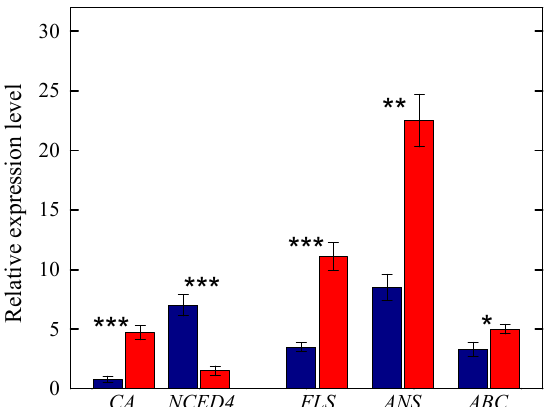
Figure 3. Relative expression levels of selected genes regulating the synthesis of MEP- ( CA , NCED4 ) and flavonoid-derived products ( FLS , ANS ), as well as the transport of flavonoids ( ABC ) in shade (blue bars) or sun (red bars) leaves of C. incanus . Data are means ± standard deviation ( n = 3). Asterisks denote significant difference: *** P < 0.001; ** P < 0.01, * P < 0.05.